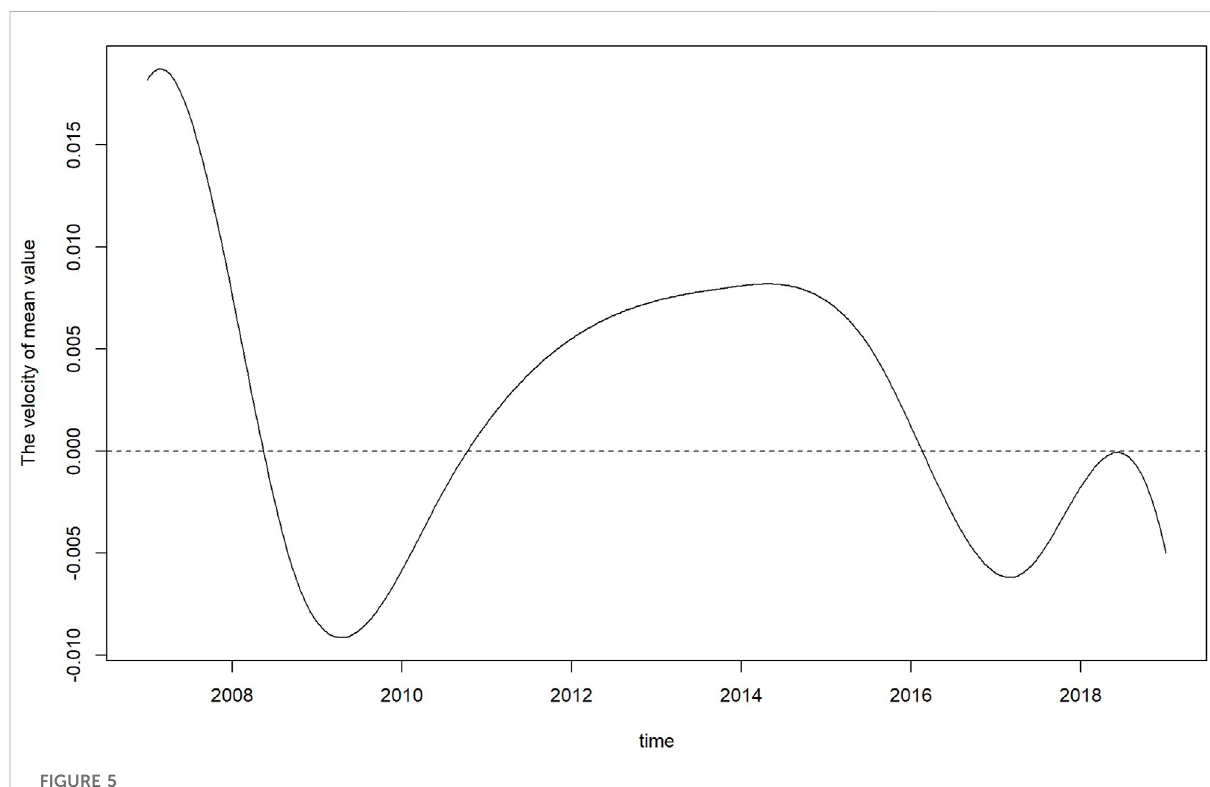
FIGURE 5 Velocity curve of the re-electri fi cation index mean